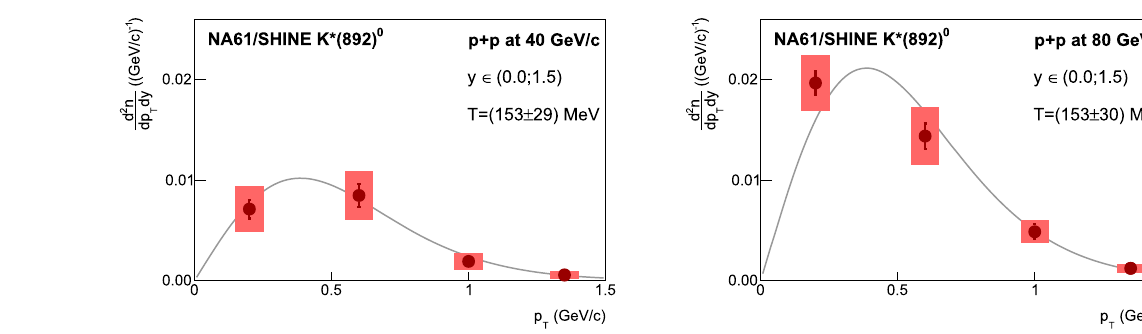
Fig. 6 The transverse momentum spectra d 2 n of K ∗ ( 892 ) 0 mesons given by Eq. (11). The numerical values are listed in Table 5. The fitted dydp T produced in inelastic p+p collisions at 40 GeV / c (left) and 80 GeV / c inverse slope parameters T are quoted in the legends (right) in rapidity range 0 < y < 1 . 5. The fitted function (solid line) is